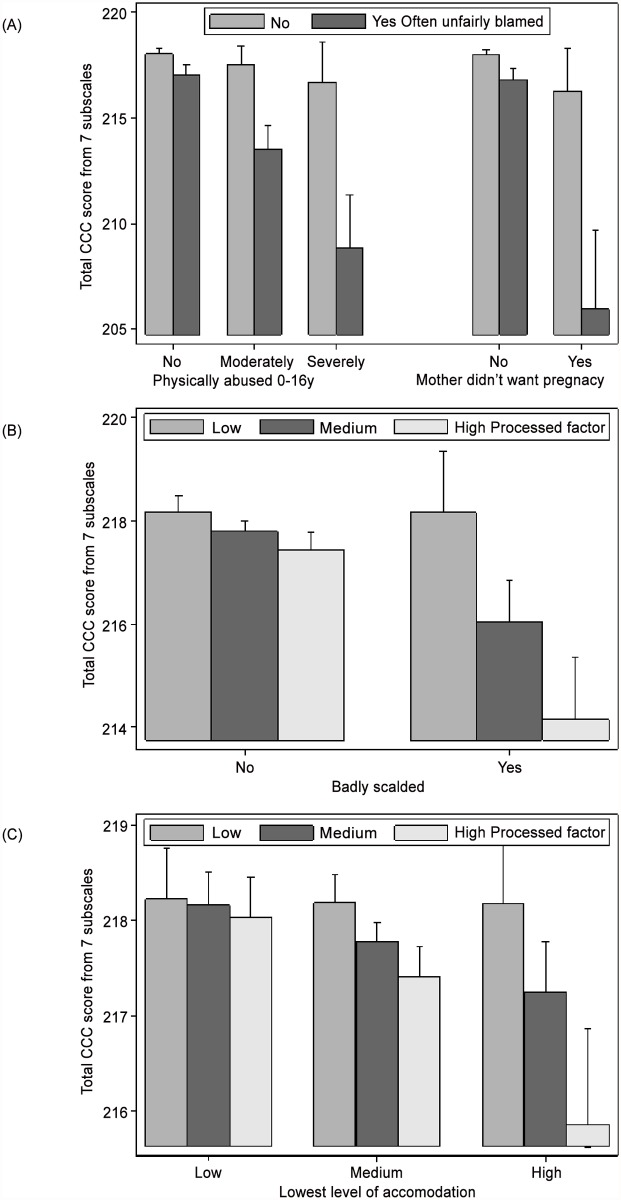
Interaction effects on the Total CCC score (N = 7613).The figure shows four interactions: two with Often unfairly blamed (A) and two with Processed dietary factor (B and C). The significance of the interactions were p = 0.000019 and 0.000022 (A), p = 0.000071 (B) and p = 0.000048 (C).